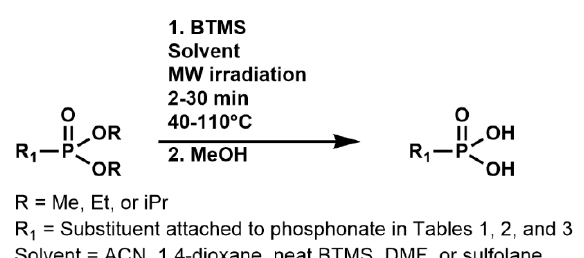
Scheme 1. General reaction scheme for microwave-assisted BTMS dealkylation in the conversion of phosphonate alkyl esters to phosphonic acids. Table 1. Results for the dealkylation reactions represented in Scheme